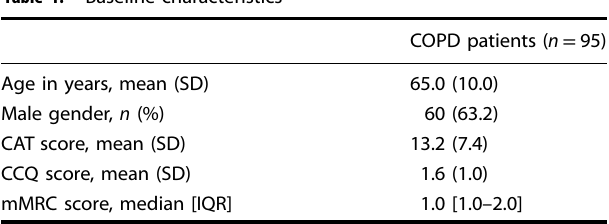
Table 1. Baseline